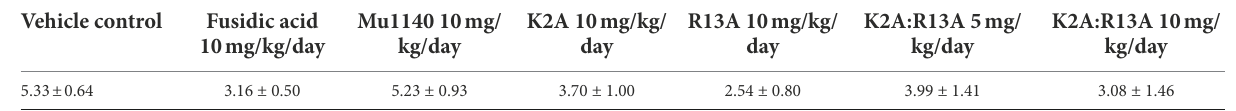
TABLE 3 Group means (±SE) of log CFU/infection site of the experimental animals being treated by fusidic acid and mutacins via topical application in an incision MRSA skin infection model. Treatment